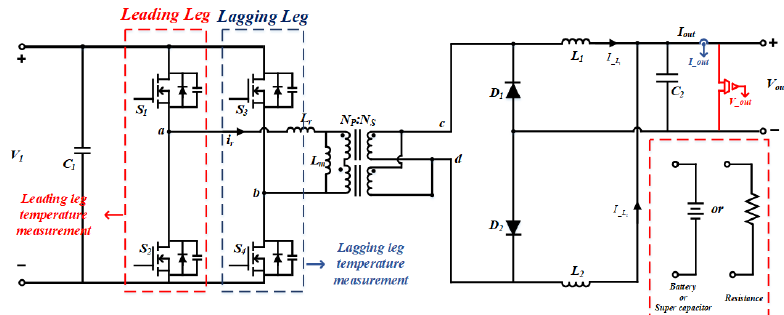
Figure 1. Circuit diagram of full-bridge converter with current doubler.